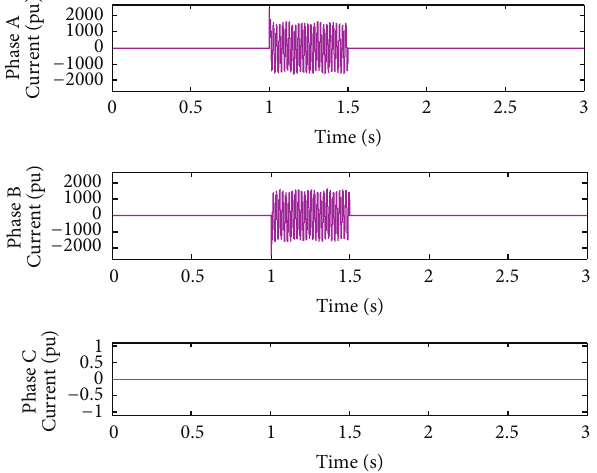
Figure 17: Fault current during LLG